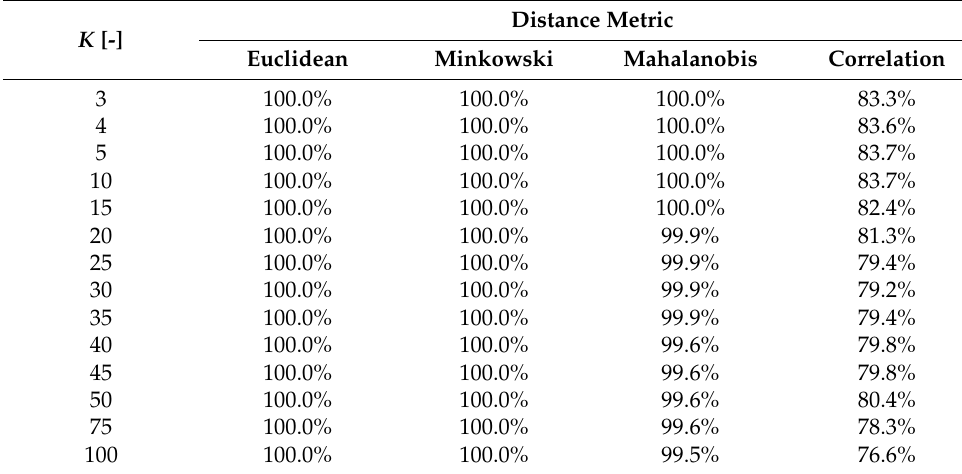
Table 3. The KNN classifier accuracies for different key